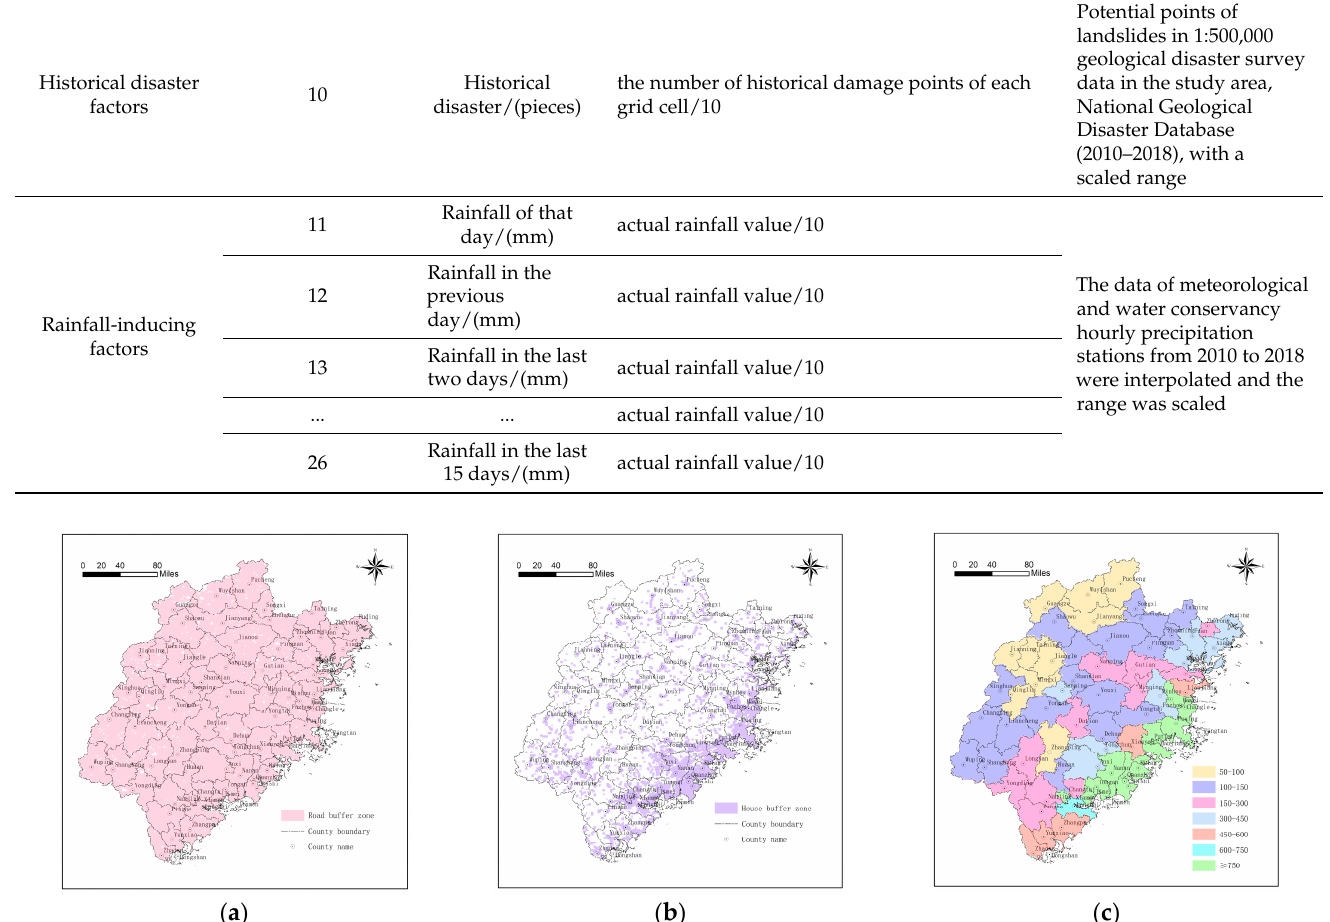
Figure 3. Hazard-affected body factors: ( a ) distance from the road, ( b ) distance from the house, ( c ) population